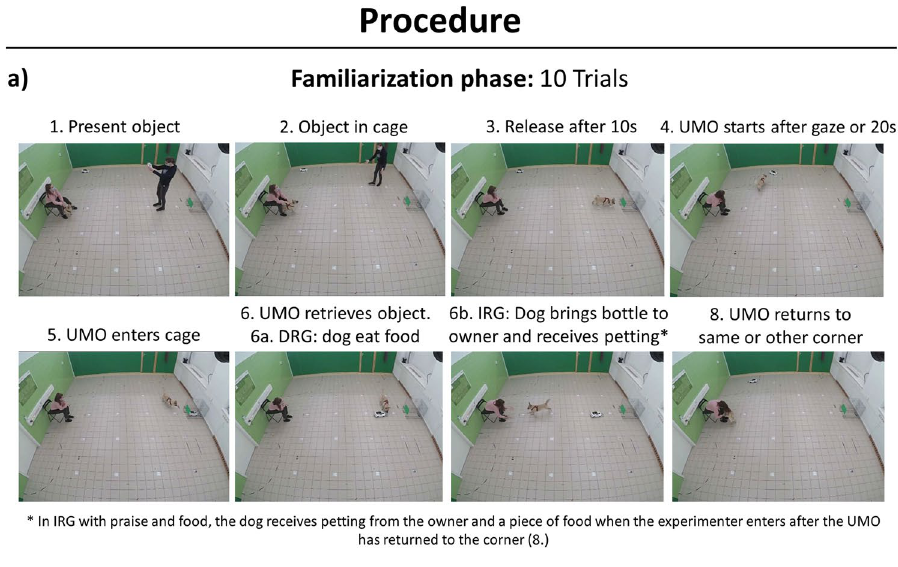
Figure 8. Experimental procedure in the ( a ) Familiarization and ( c ) Test phase, as well as ( b ) the change in setup between the phases. The set up was the same in the Pretest without the cage. The object was a piece of food in the DRG (also the reward) and a plastic bottle in the IRG that they fetched for the owner in return of petting and praise. In the Familiarization phase, the UMO returned to the same starting corner in the Same-side subgroup, while it altered between the two corners in the Changing-side